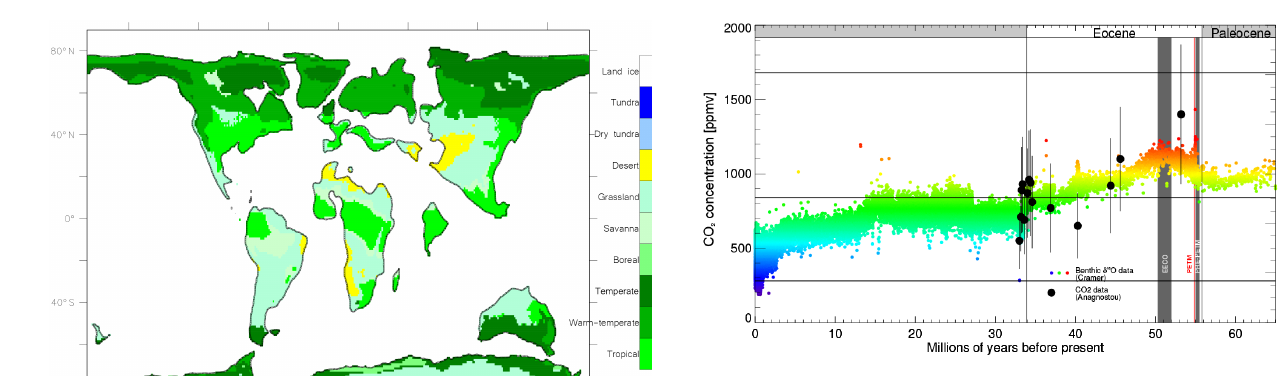
Figure 5. Atmospheric CO 2 as derived from boron isotopes in the Eocene by Anagnostou et al. (2016) (black circles and error es- timates). Horizontal lines show 280ppmv (typical pre-industrial value), and 840 and 1680ppmv, corresponding to the deepmip- stand-3xCO2 and deepmip-stand-6xCO2 simulations. Also shown are the DeepMIP palaeointervals – EECO (grey shaded region), pre- PETM (grey shaded region), and the PETM (vertical red line) – and the climate evolution over the last 65 million years, as expressed by the benthic oxygen isotope record of Cramer et al. (2009) (coloured dots). Note that the formal definition of the start and end date of each time period is still to be